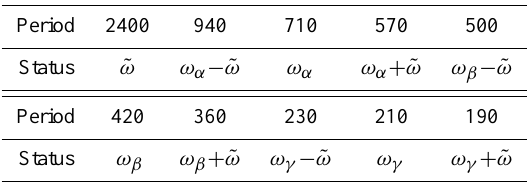
Table 1. The results of the bispectral analysis of radiocarbon series. Harmonic periods are shown in